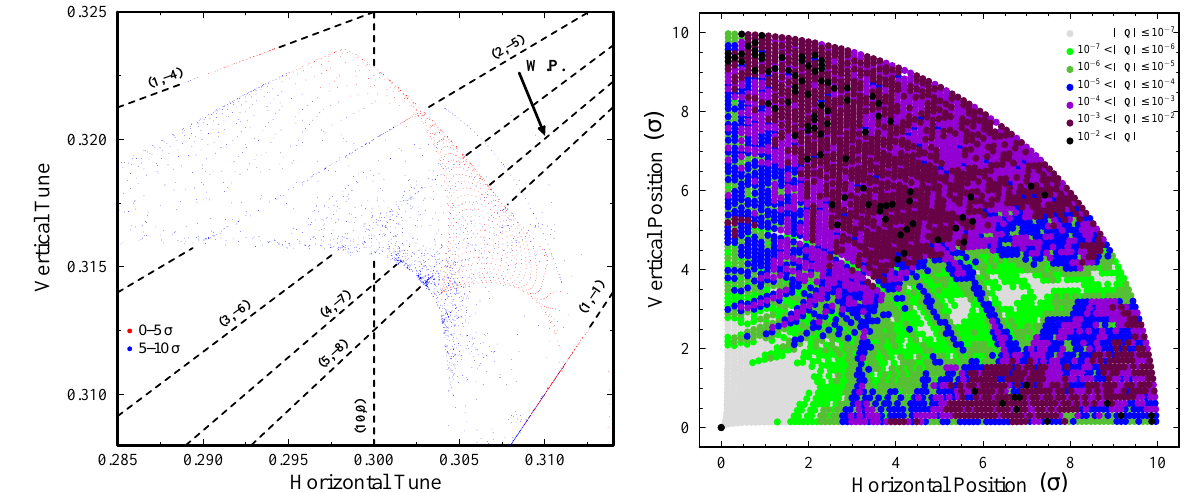
FIG. 3. (Color) Tune footprint and diffusion map for a model including the head-on and long-range collision effect and the KEK triplet nonlinearities, for a 200 m rad crossing angle. The symbols are the same as in Figs. 1 and 2. crossing angle ( 300 m rad).